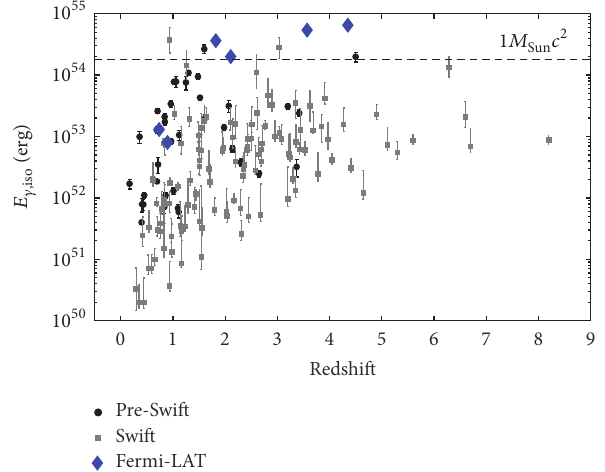
Figure 3: Isotropic prompt gamma-ray energy release ( 𝐸 𝛾, frame 1keV–10 MeV bandpass) of GRBs with measured redshift. One can see a large range of 𝐸 𝛾,